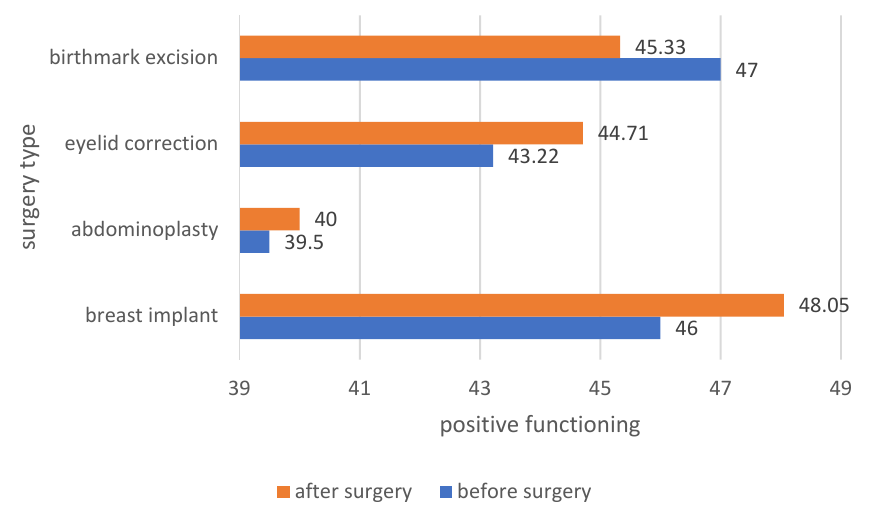
Figure 8. Comparison of the sense of positive functioning among patients before and after the pro- cedure.